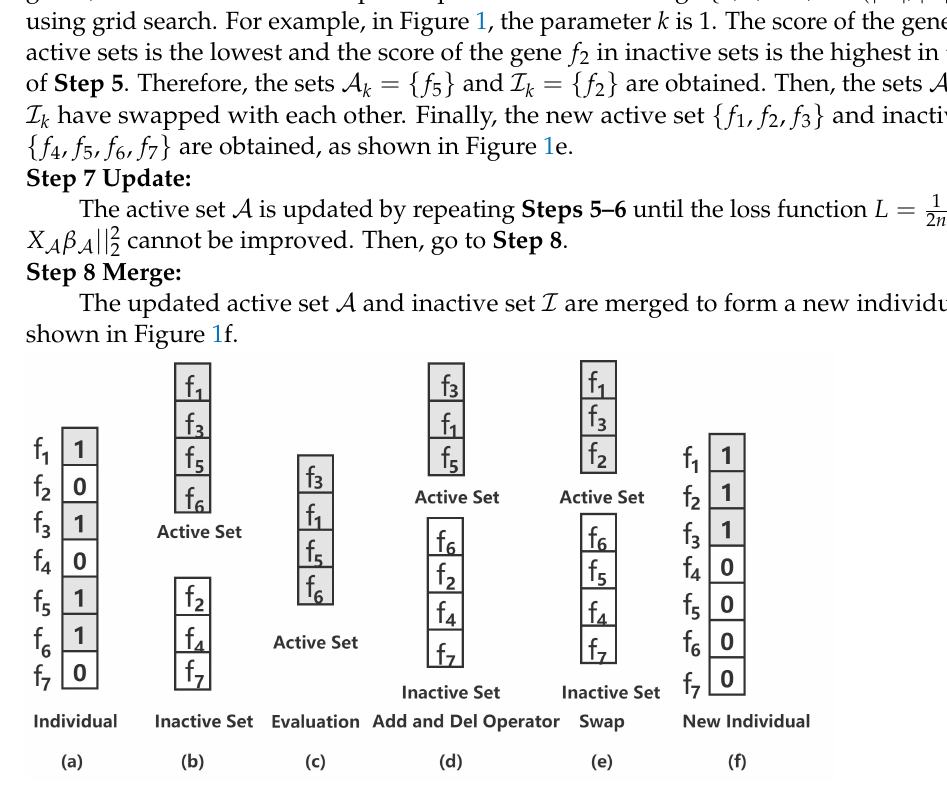
Figure 1. Example of the improved splicing method ( a ) Individual. ( b ) Individual Segmentation. The individuals are divided into active sets and inactive sets. ( c ) Evaluation. The score of each gene in an active set is evaluated in terms of backward sacrifice. ( d ) add and del Operators. Some genes with the lowest scores in active sets are deleted, then added into inactive sets. ( e ) Swap. A gene with the lowest score ( f 5 ) in an active set and a gene with the highest score ( f 2 ) in an inactive set swap each other. ( f ) Merge. The active set and inactive set are merged into a new